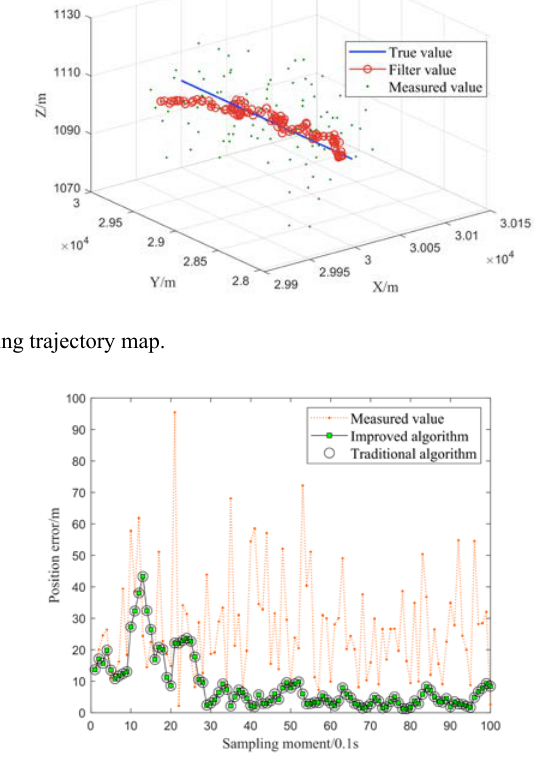
Fig. 5. Positioning error when there is no disturbance.